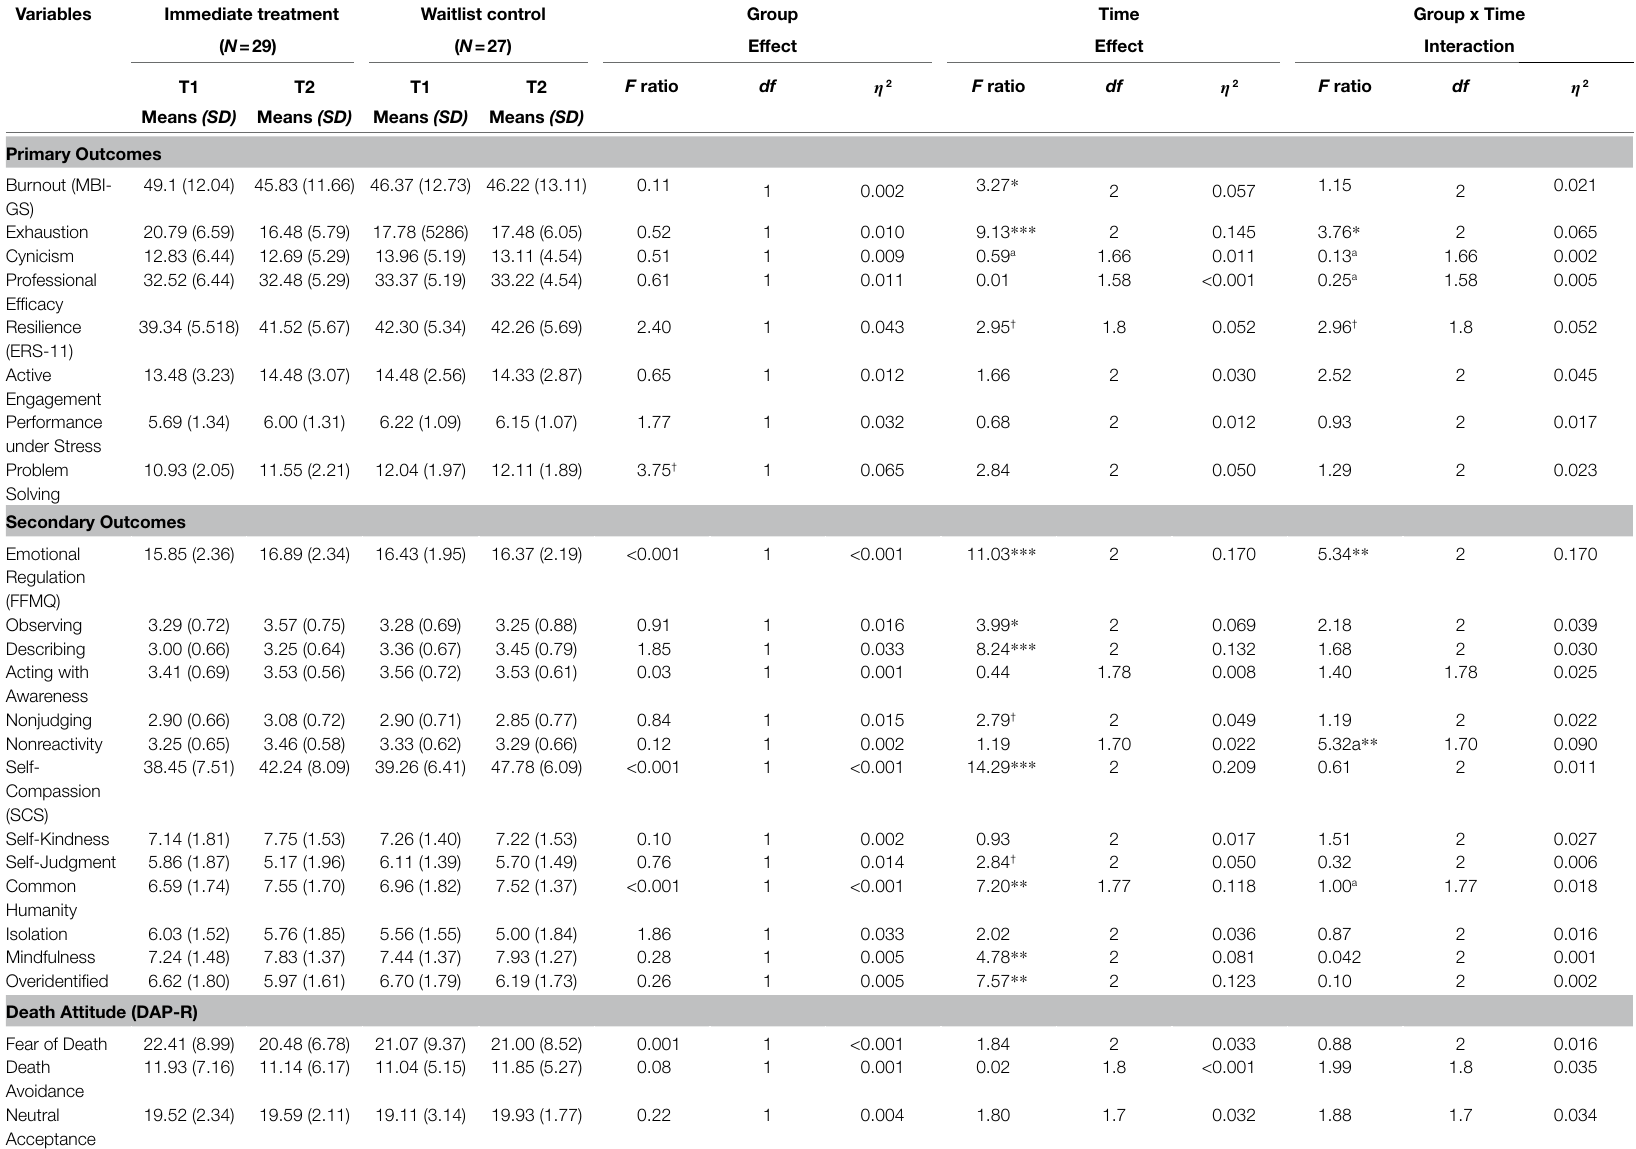
TABLE 3 | Outcome comparisons between treatment and control groups using mixed model ANOVAs. Variables Immediate treatment Waitlist control Group Time Group x Time Effect Effect Interaction